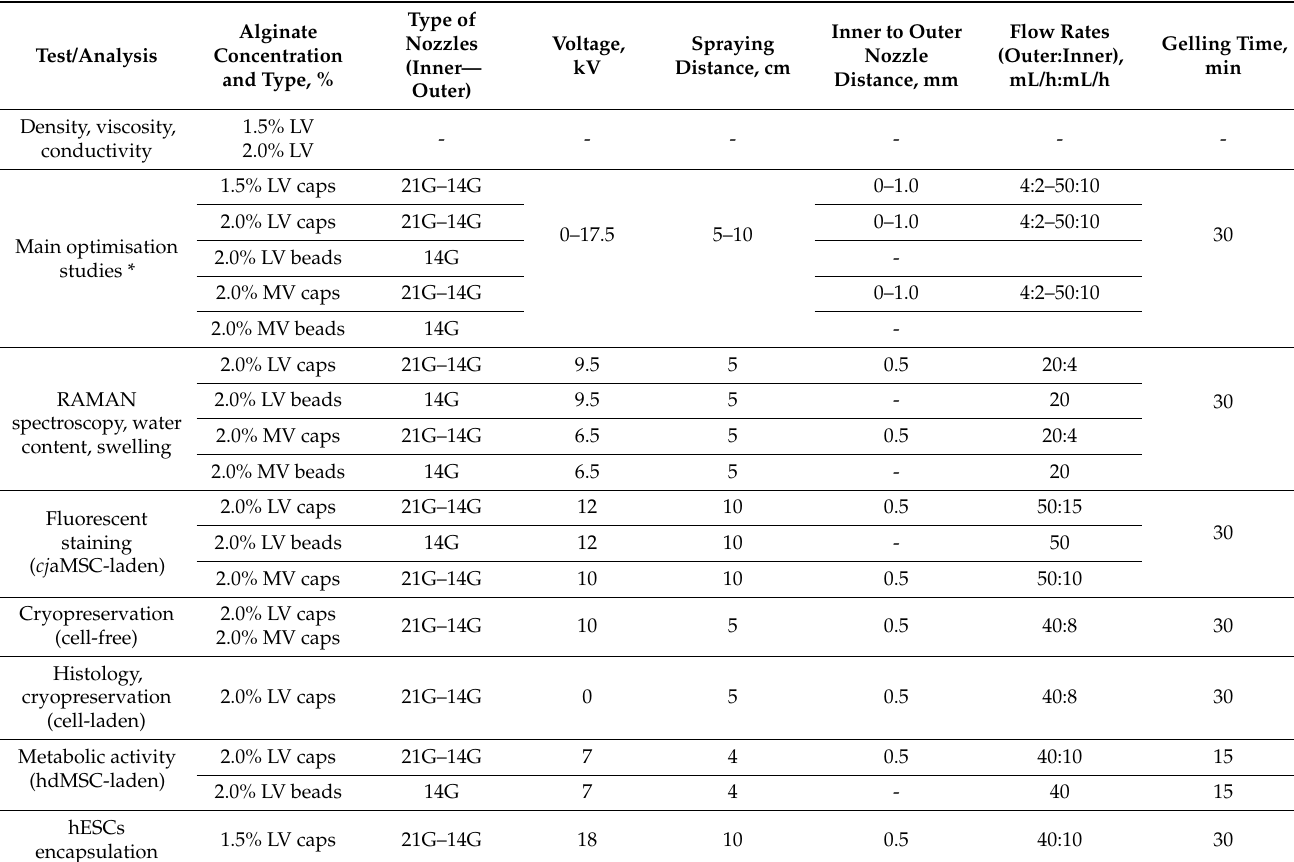
Figure 12. Coaxial encapsulation of cells using electrospraying. ( A ) General view of the set-up used for coaxial encapsu- lation. ( B ) Custom-developed coaxial nozzle. ( C ) Core-shell capsules laden with cj aMSCs (cell encapsulation density 5 × 10 6 cells/mL). Scale bar is 500 µm. Table 2. Summary of process parameters used for solution characterisation and preparation of core-shell capsules and solid beads.